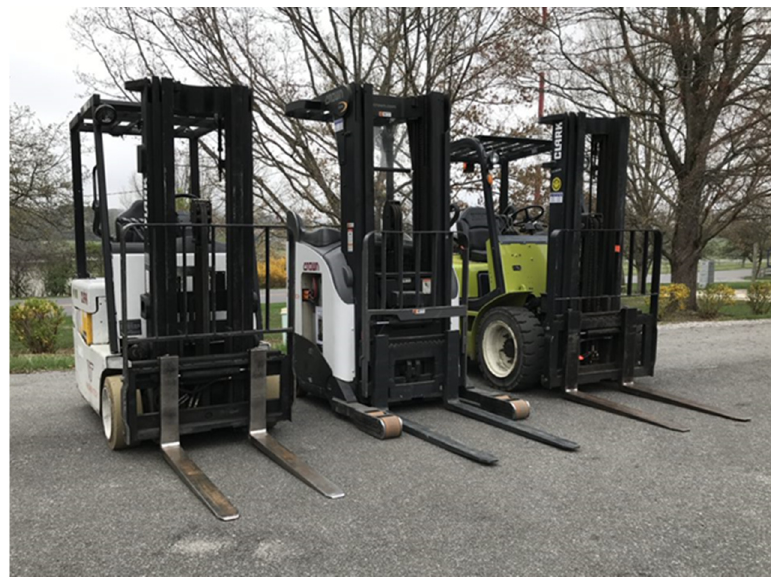
Figure 1. Forklifts used in the study (left to right: gas, electric, reach). Table 1. Specifications of the forklifts used in the study.